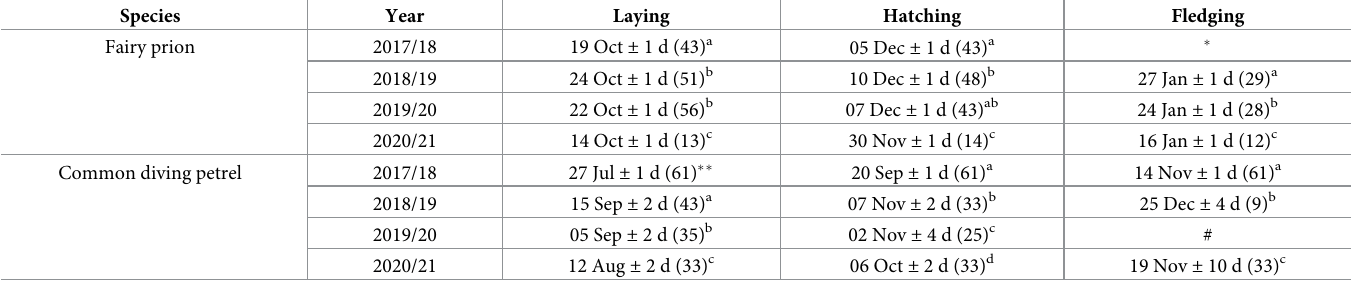
Table 1. Timing of laying, hatching and fledging dates (mean ± SE) of fairy prions ( Pachyptila turtur ) and common diving petrels ( Pelecanoides urinatrix ) from Kanowna Island, Bass Strait, south-eastern Australia. For each period/species, values not sharing the same superscript letter (a, b, c or d) are significantly different (Mann-Whitney U test: P < 0.05). Sample sizes are provided in parentheses.